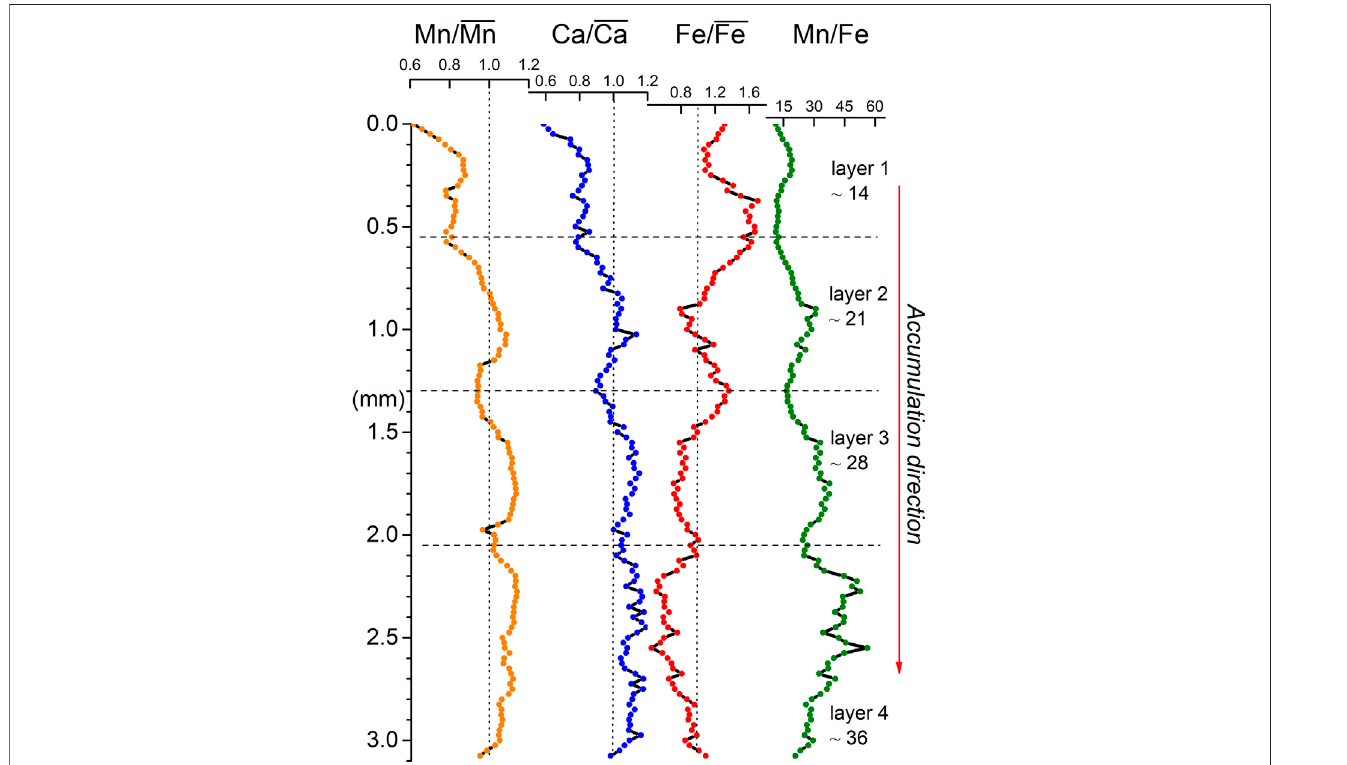
FIGURE 9 | Mn/Mn, Fe/Fe, Ca/Ca, and Mn/Fe pro fi les along the growth direction of sample GC, obtained by μ XRF (see Figure 2 for the position on the sample). Horizontal dotted lines mark the boundary of each cycle (minimum Mn/Fe values) corresponding to the discontinuity surfaces between layers (cyan arrows in Figure 2 ).